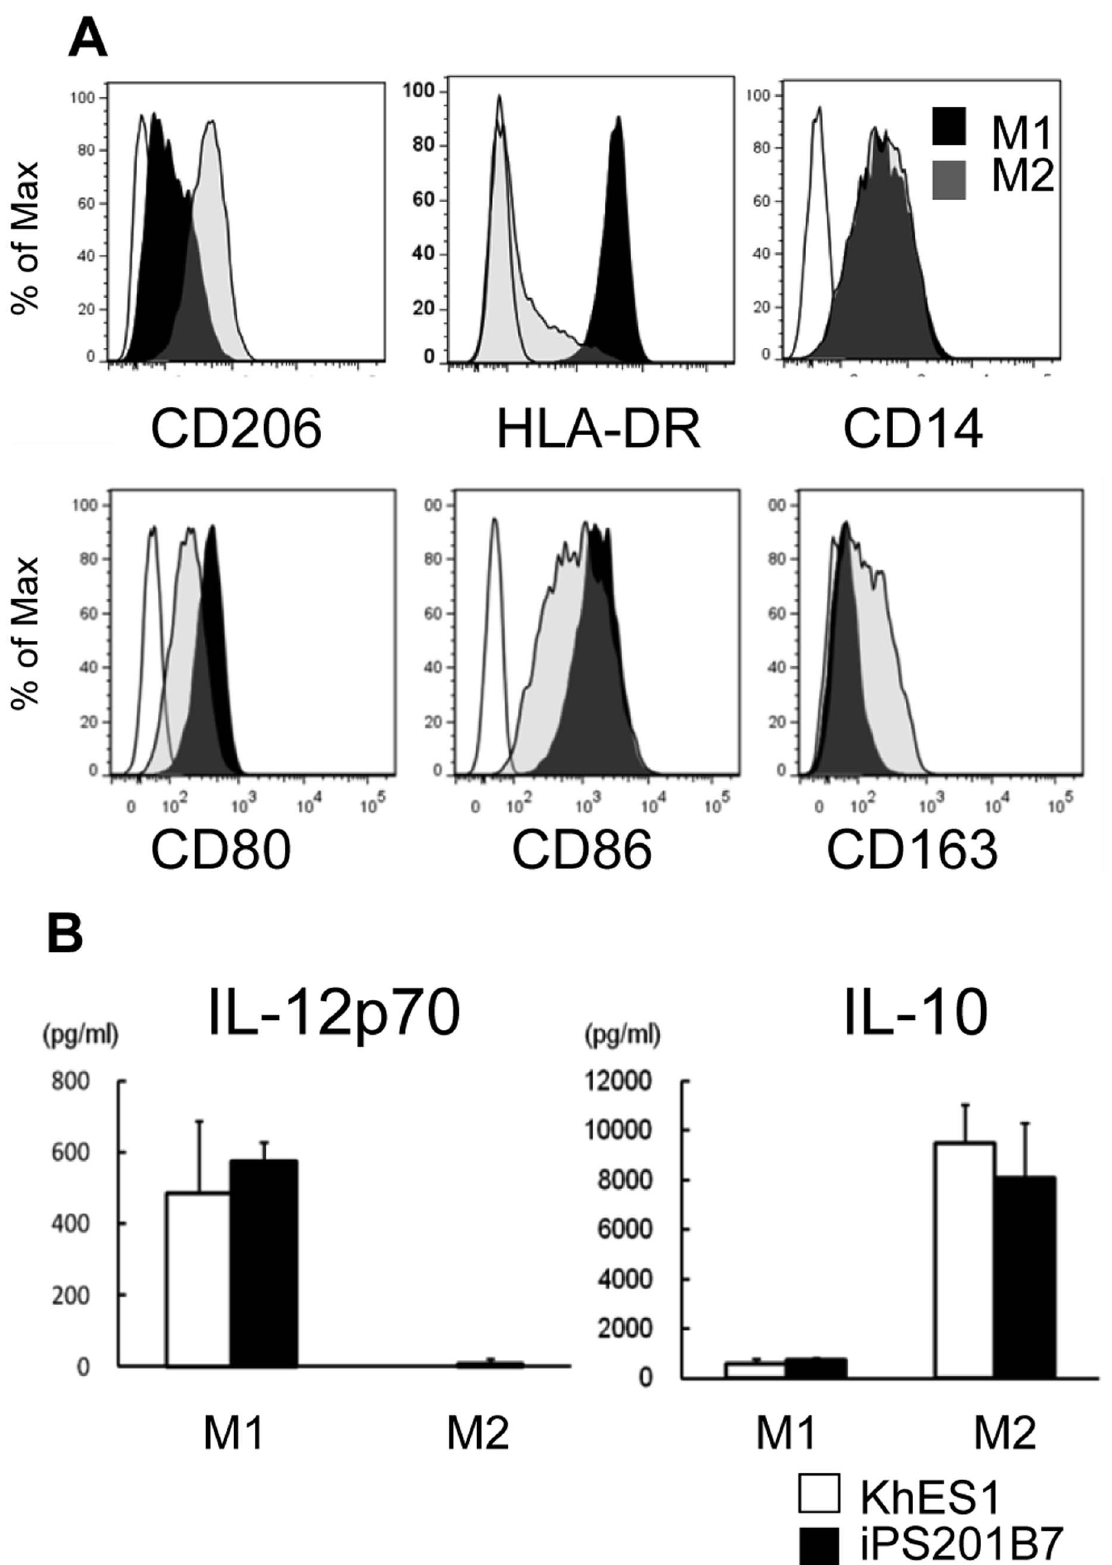
Figure 5. Functional assays for M1/M2 macrophages derived from pluripotent stem cells. (A) Flow cytometric analysis of M1/M2 macrophages derived from pluripotent stem cells. (B) The levels of IL-12p70 and IL-10 in supernatants of culture medium with M1/M2 macrophages derived from pluripotent stem cells 24 hours after LPS stimulation. The data of KhES1-derived cells are shown as representative.